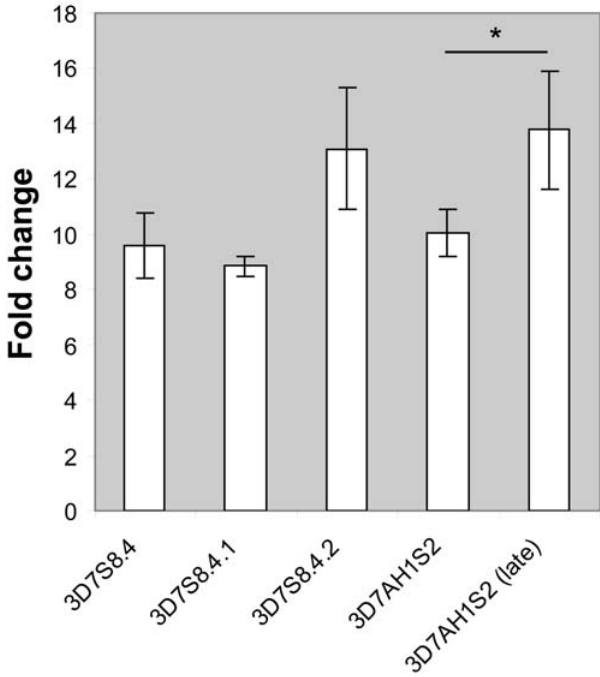
Figure 7. Quantitative differences in complete cycle multipli- cation rates between different parasites. Mean of fold change per erythrocytic cycle for at least three consecutive 48 hour cycles were calculated from blood smear parasitemias. Significant differences between ‘‘early’’ versus ’’late’’ generation clones (3D7S8.4 vs 3D7S8.4.1; 3D7S8.4 vs 3D7S8.4.2 and 3D7AH1S2 vs 3D7AH1S2 late) were determined using an unpaired Students t-test at a 5% significance level. Analysis was performed in SPSS version 12.0. *P , 0.05; Significantly higher multiplication rate was observed in the late S2- clone. The same trend was also observed in the other VAR2CSA expressing late generation clone S8.4.2, the difference here however was not statistically significant